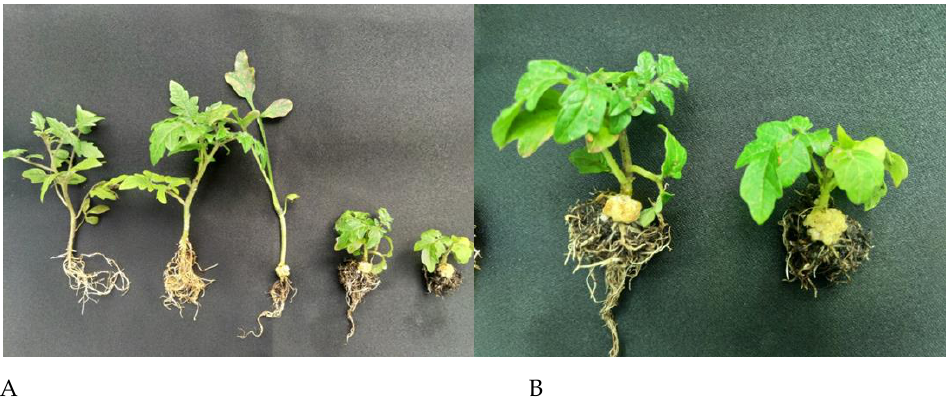
Figure 2. The tumor-forming ability of selected isolates on tomato in the greenhouse. ( A ). Healthy to tumor formed from the left of pathogenic isolates. ( B ). Close-up of tumor formation with Agrobacterium tumefaciens C58.